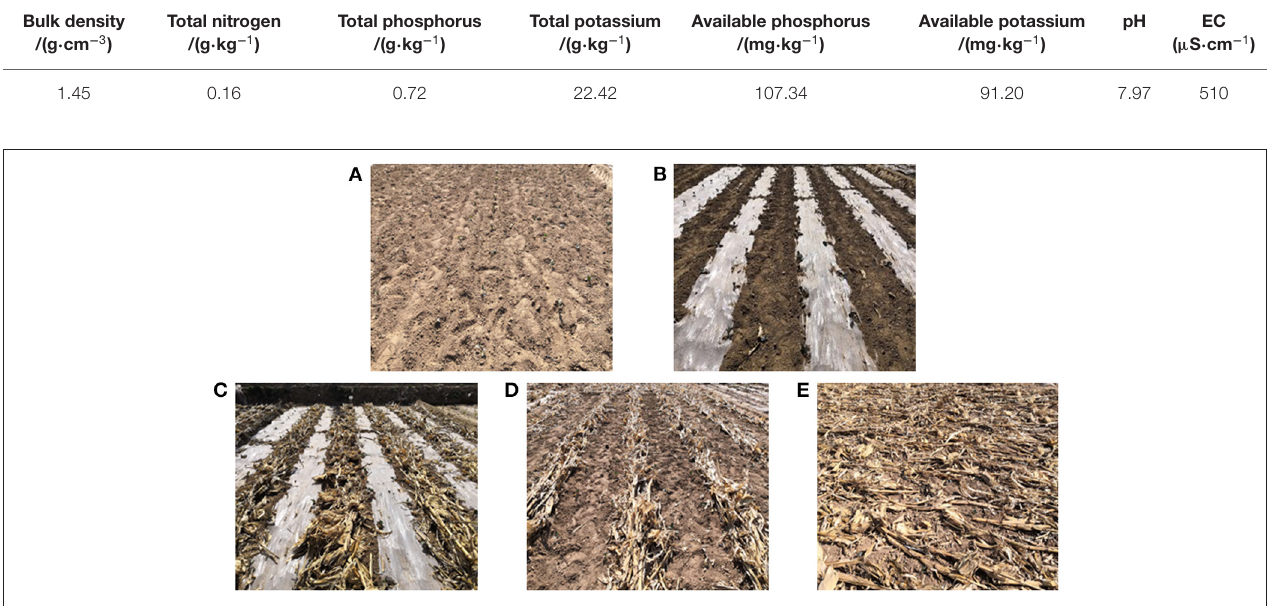
FIGURE 1 | Different mulching patterns applied in this experiment. (A) Open field without mulching (CK1): No mulching was applied on ridges or in furrows. (B) Plastic film mulch (CK2): transparent plastic film was mulched on the ridges, but no mulching was applied in the furrows. (C) Dual mulching with straw and mulching film (T1): ridges were covered with transparent mulching film, whereas corn stalks evenly covered the furrows. (D) Straw mulch between rows (T2): no plastic film mulch was applied on the ridges, and furrows were evenly covered with corn stalks. (E) Full straw coverage (T3): All ridges and furrows were evenly covered with corn stalks. In all plots, loose-curd cauliflower was planted on the